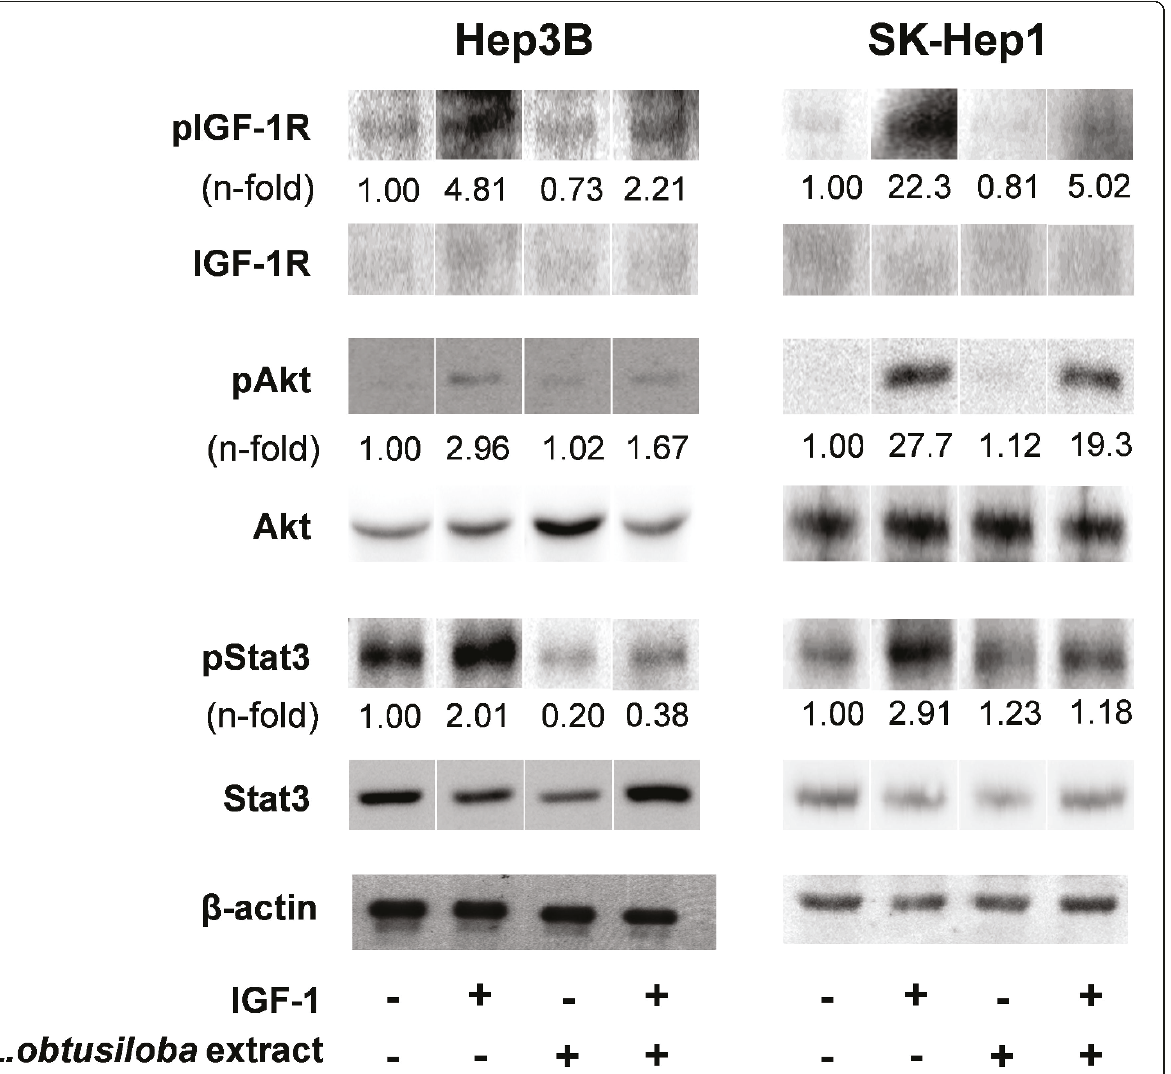
Figure 2 Effects of L.obtusiloba extract on the basal and IGF-1-induced IGF-1R signal transduction . As described for Table 2, HCC cells treated for 24 h with 100 μ g/ml L.obtusiloba extract, 125 ng/ml IGF-1, a combination of both or untreated cells were lysed. Whole cell lysates were analyzed by western-blot with antibodies specific for phosphorylated and normal IGF-1R and its downstream targets Akt and Stat3. Bands were visualized by chemiluminescence. Blots are representative for three independent experiments. Quantification of the protein-activation (n- fold to control values) were taken from table